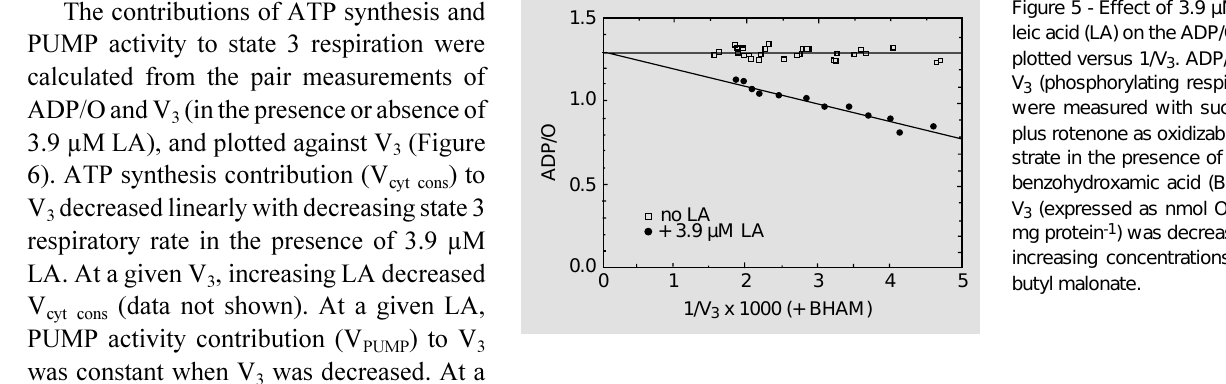
Figure 6 - Contributions of ATP synthesis and plant uncoupling mitochondrial protein (PUMP) activity in state 3 respiration.